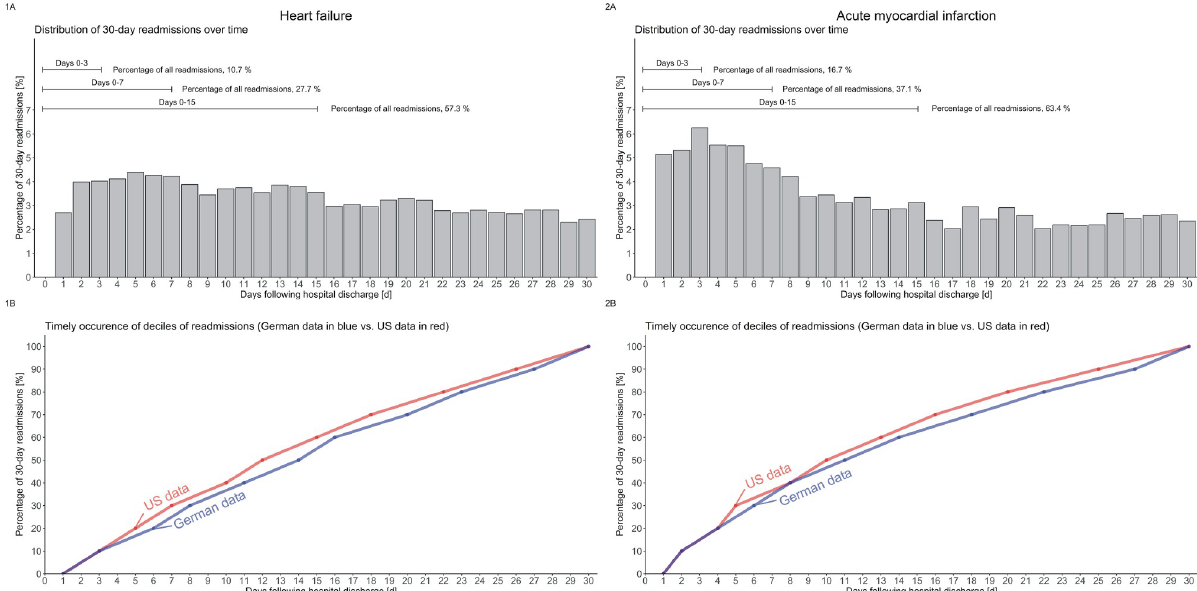
Fig 1. Distribution of 30-d all-cause readmissions after admission for heart failure and acute myocardial infarction, and comparison of their time course with the results of an external reference. Upper panels (1A and 2A) show the distribution of all 30-d readmissions in an older German population for the years 2012–2016. Lower panels (1B and 2B) show the corresponding day of readmission for each decile of hospital readmissions. As examples, for acute myocardial infarction (panel 2B) 30% of readmissions, and for heart failure (panel 1B) 20% of readmissions were reached one day later in the German compared to the US population (day 6 vs. day 5).